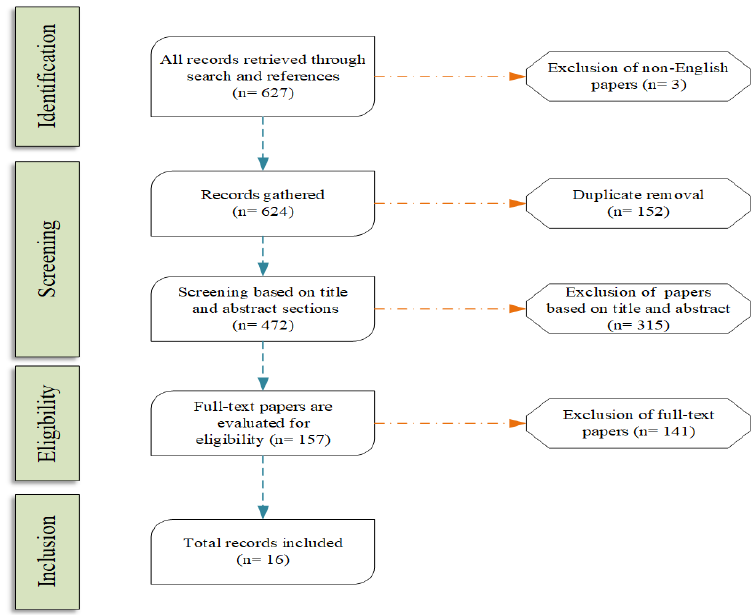
Figure 1. Survey method structure.